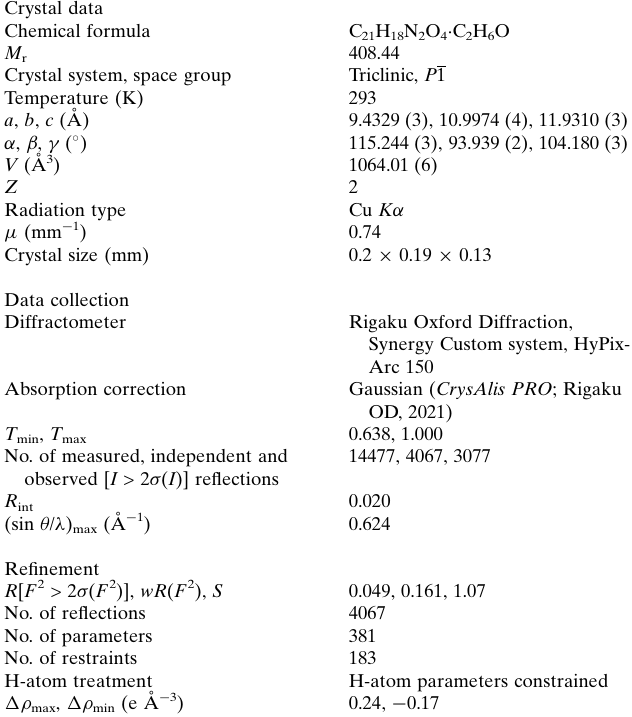
Table 2 Experimental details. Crystal data Chemical